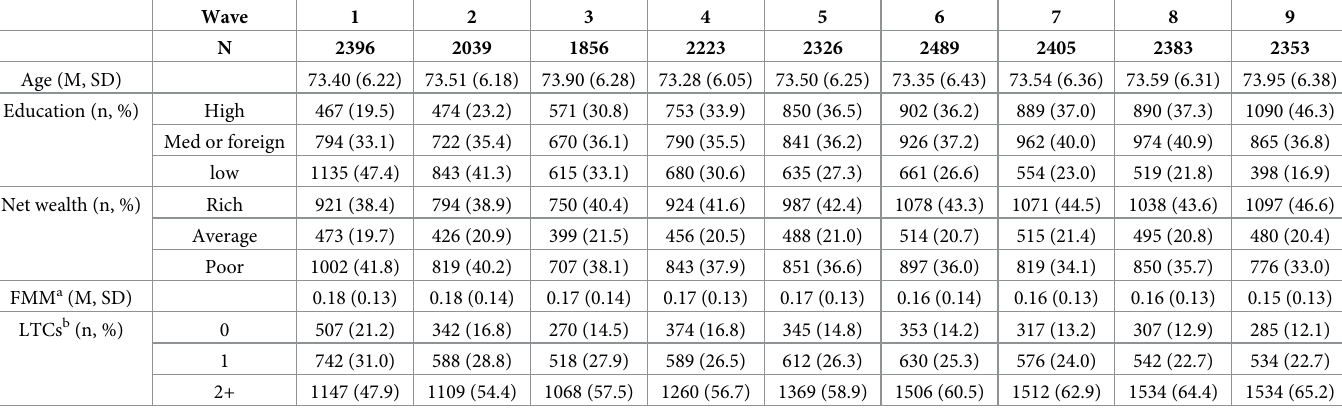
Table 1. Summary statistics for five determinants and FMM for males across the nine waves.